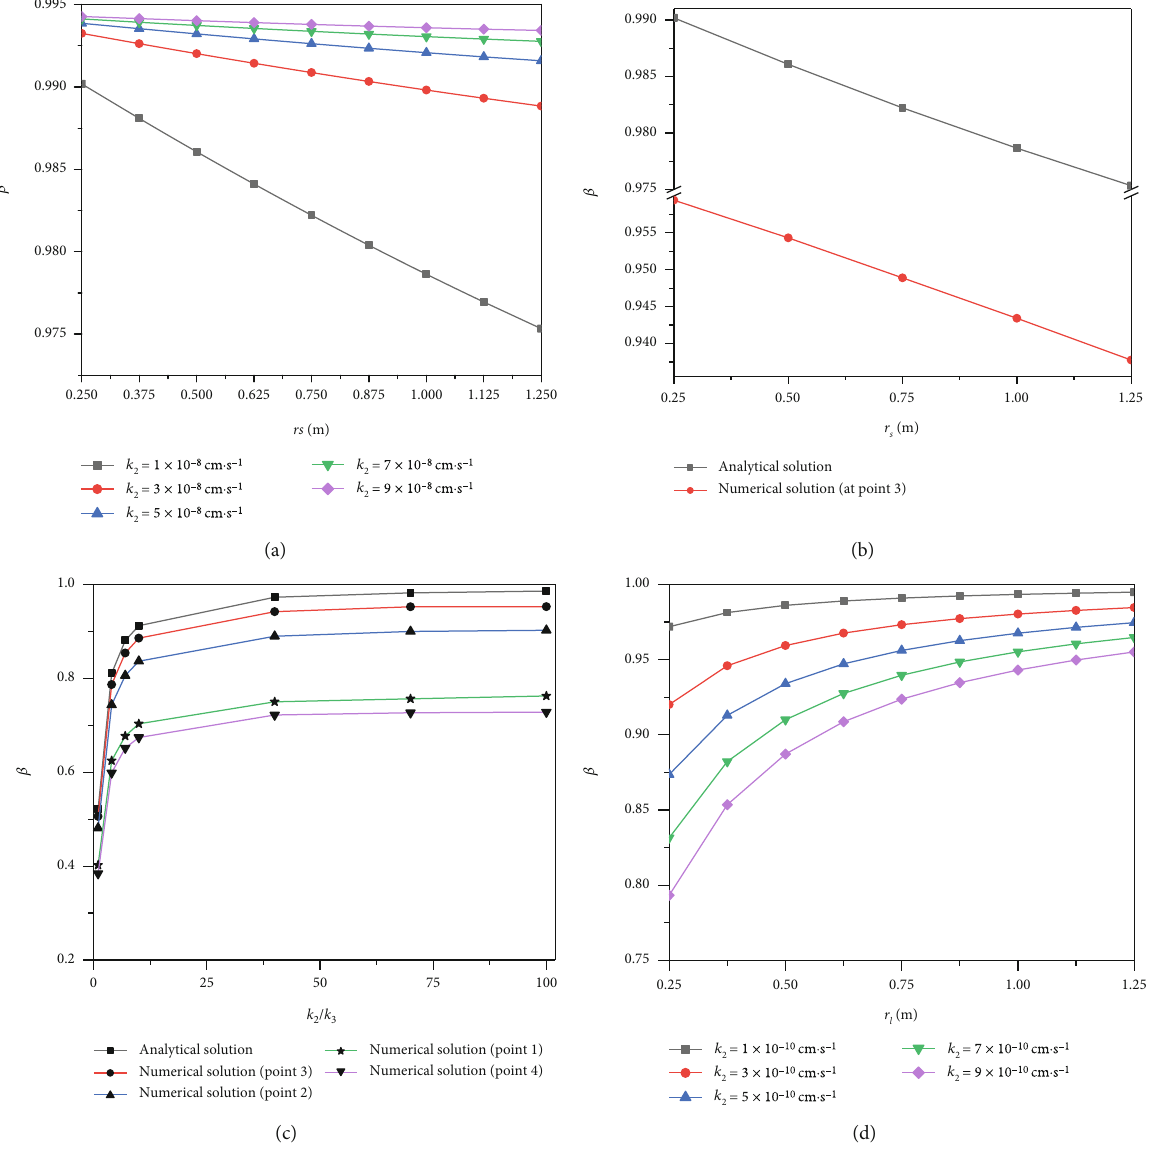
Figure 6: Relationship between β and the initial support. (a) Relationship between β and r theoretical solution. (c) Relationship between β and k 2 / k 3 . (d) Relationship between β and r